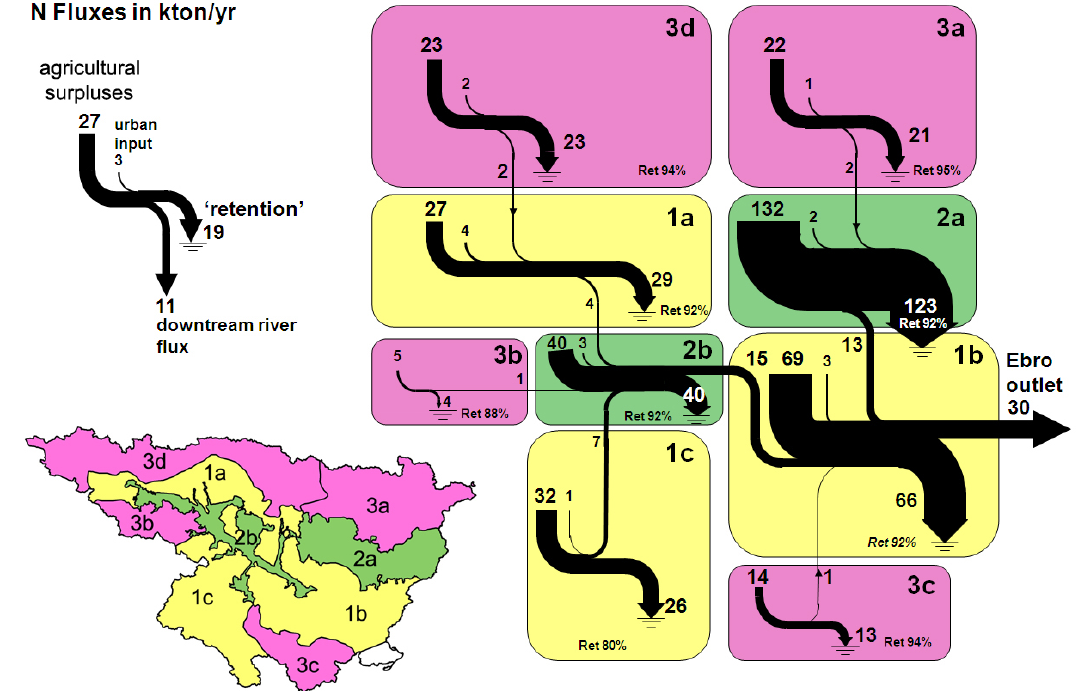
Fig. 8. Schematic diagram of the inter- and intra-territorial units N fluxes.